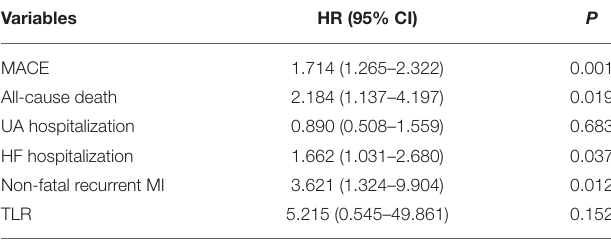
TABLE 3 | Multivariate COX regression analysis of each adverse